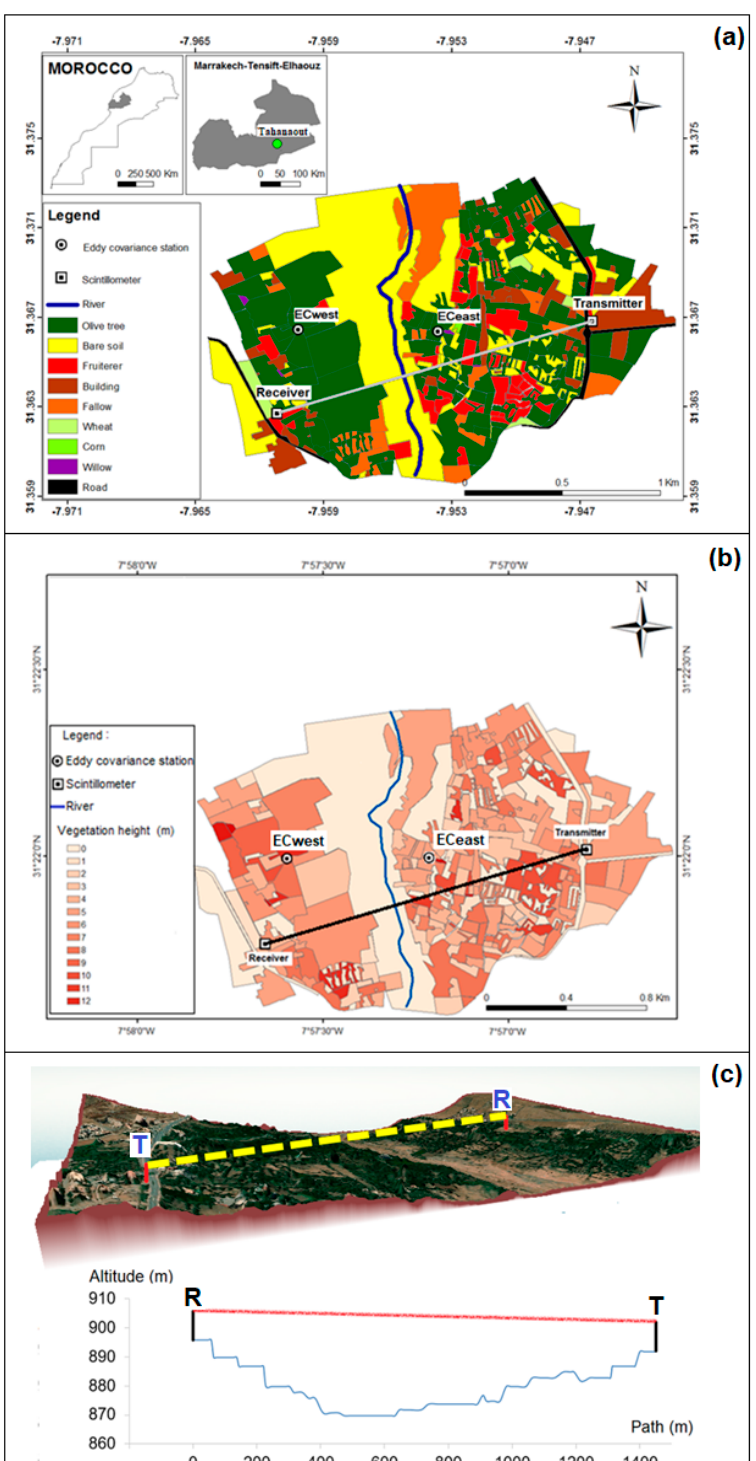
Figure 1. ( a ) Location of the eddy covariance stations and of the scintillometer transmitter (T) and receiver (R) superimposed on the land use map of the study site. ( b ) Vegetation height map of the study site. ( c ) Google Earth image draped on the DEM of the area (8-m DEM derived from PLEIADE data), scintillometer path and elevation along the scintillometer